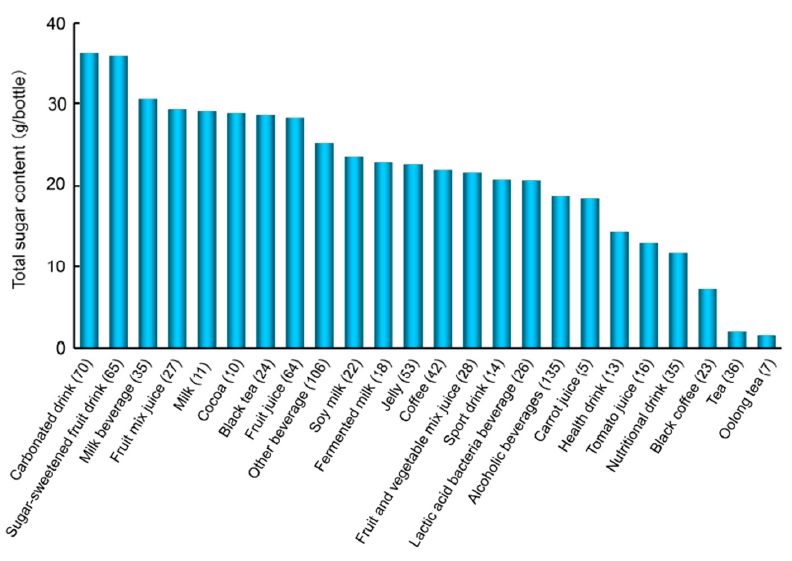
Figure 4. Average total sugar contents in commonly consumed beverages in Japan (modified from [103]). Beverages were classified according to the JAS.